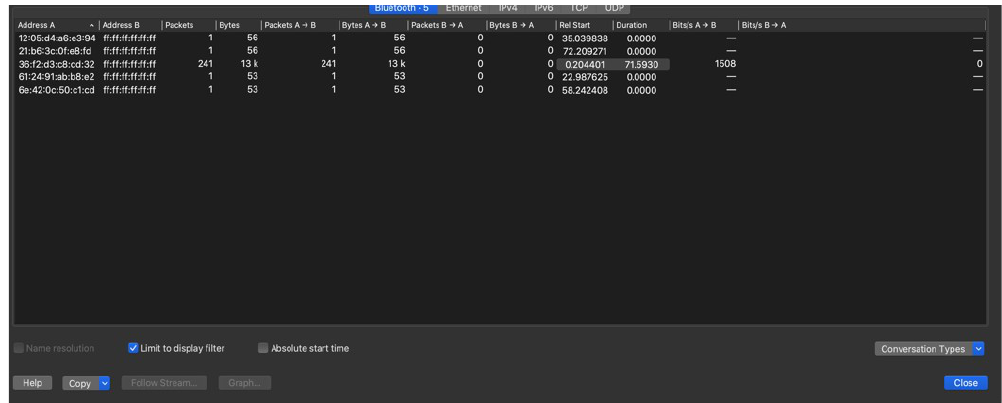
Figure 3. Wireshark